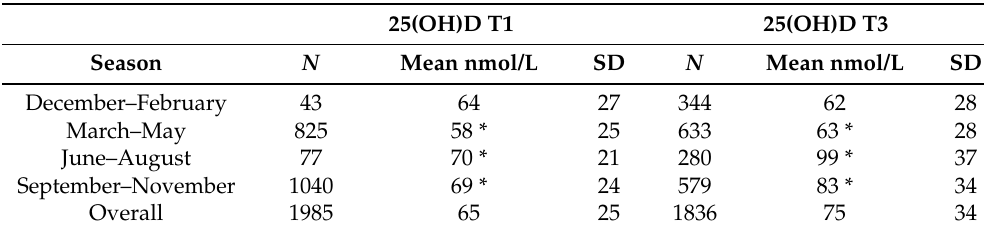
Table 4. Mean and SD 25(OH)D at T1 and T3, and according to season at